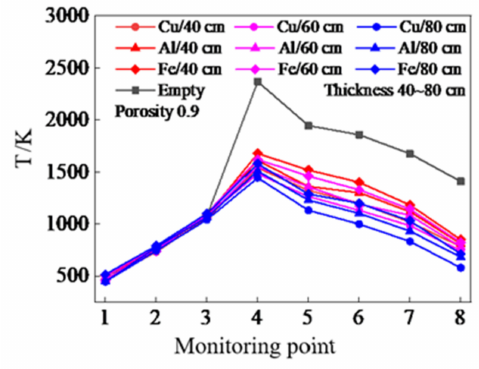
Figure 10. Maximum temperature at each monitoring